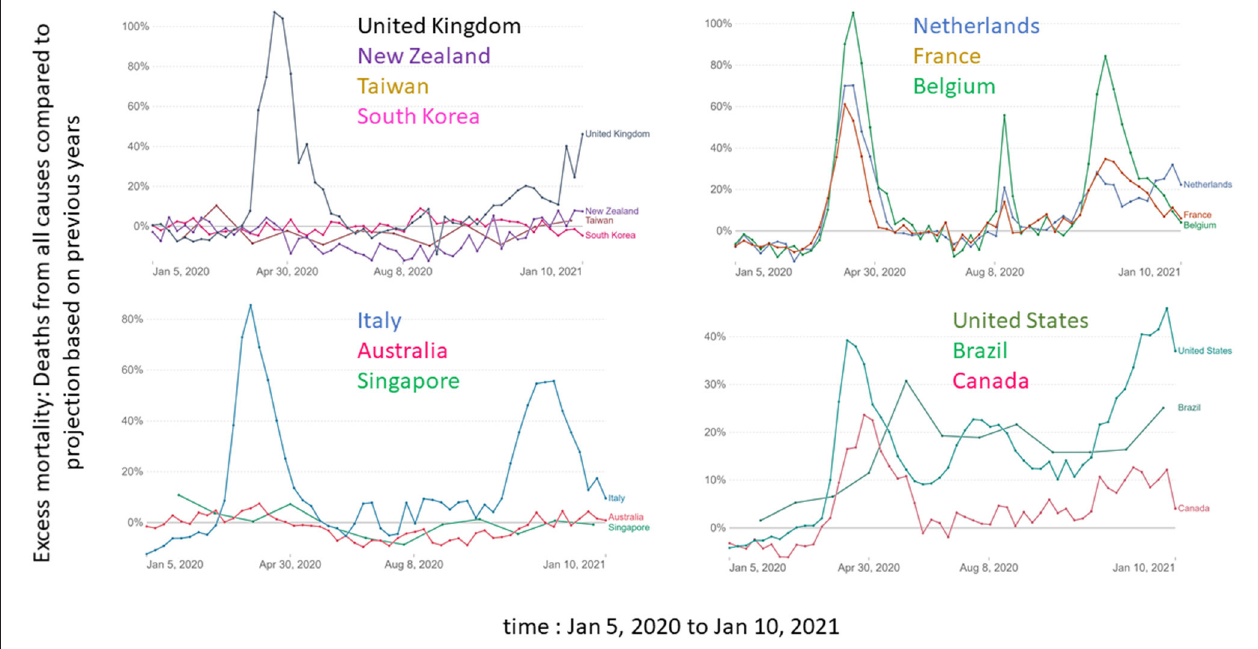
FIGURE 3 | Comparison of excess mortality (Deaths from all causes compared to projection based on previous years) for Australia, Belgium, Brazil, Canada, France, Italy, Netherlands, New Zealand, South Korea, Taiwan, United Kingdom and United States between Jan 5, 2020 and Jan 10, 2021. The data comes from https://